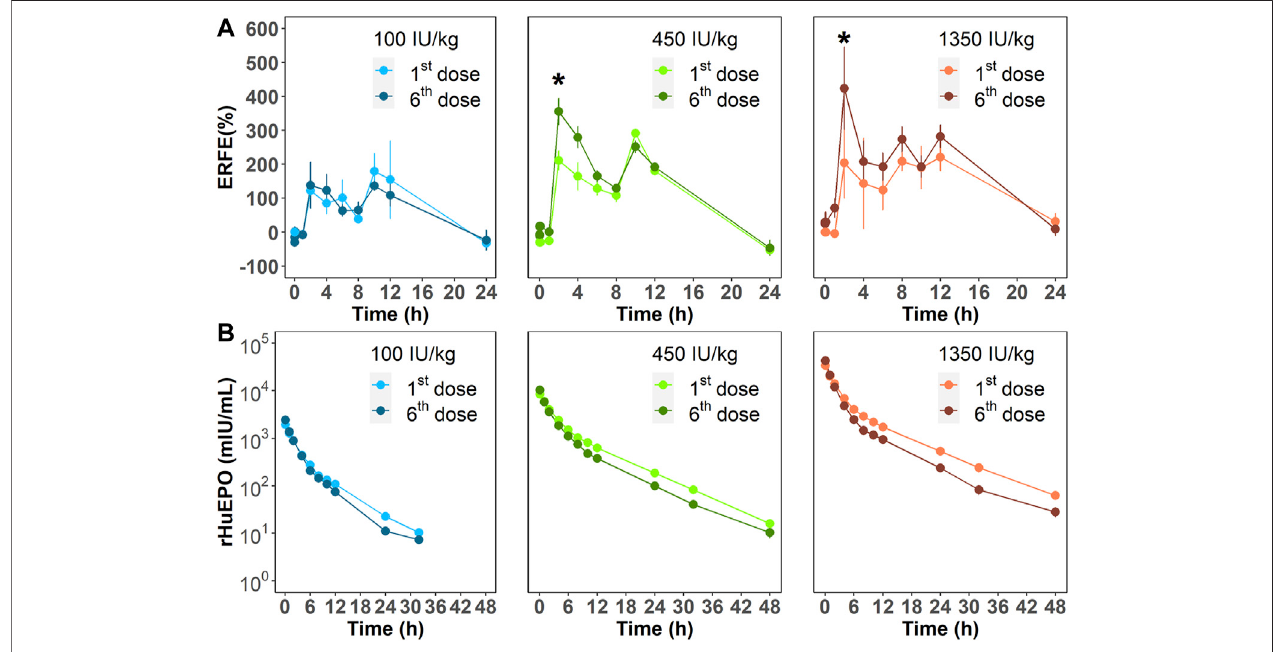
FIGURE 3 | (A) ERFE responses after the fi rst and sixth rHuEPO dose (100, 450, or 1350 IU/kg) and (B) corresponding pharmacokinetic pro fi les. Data are presented as means ± SD ( n = 3 at each time point; *p < 0.05, comparison of ERFE response after the fi rst dose versus the sixth dose at the indicated time